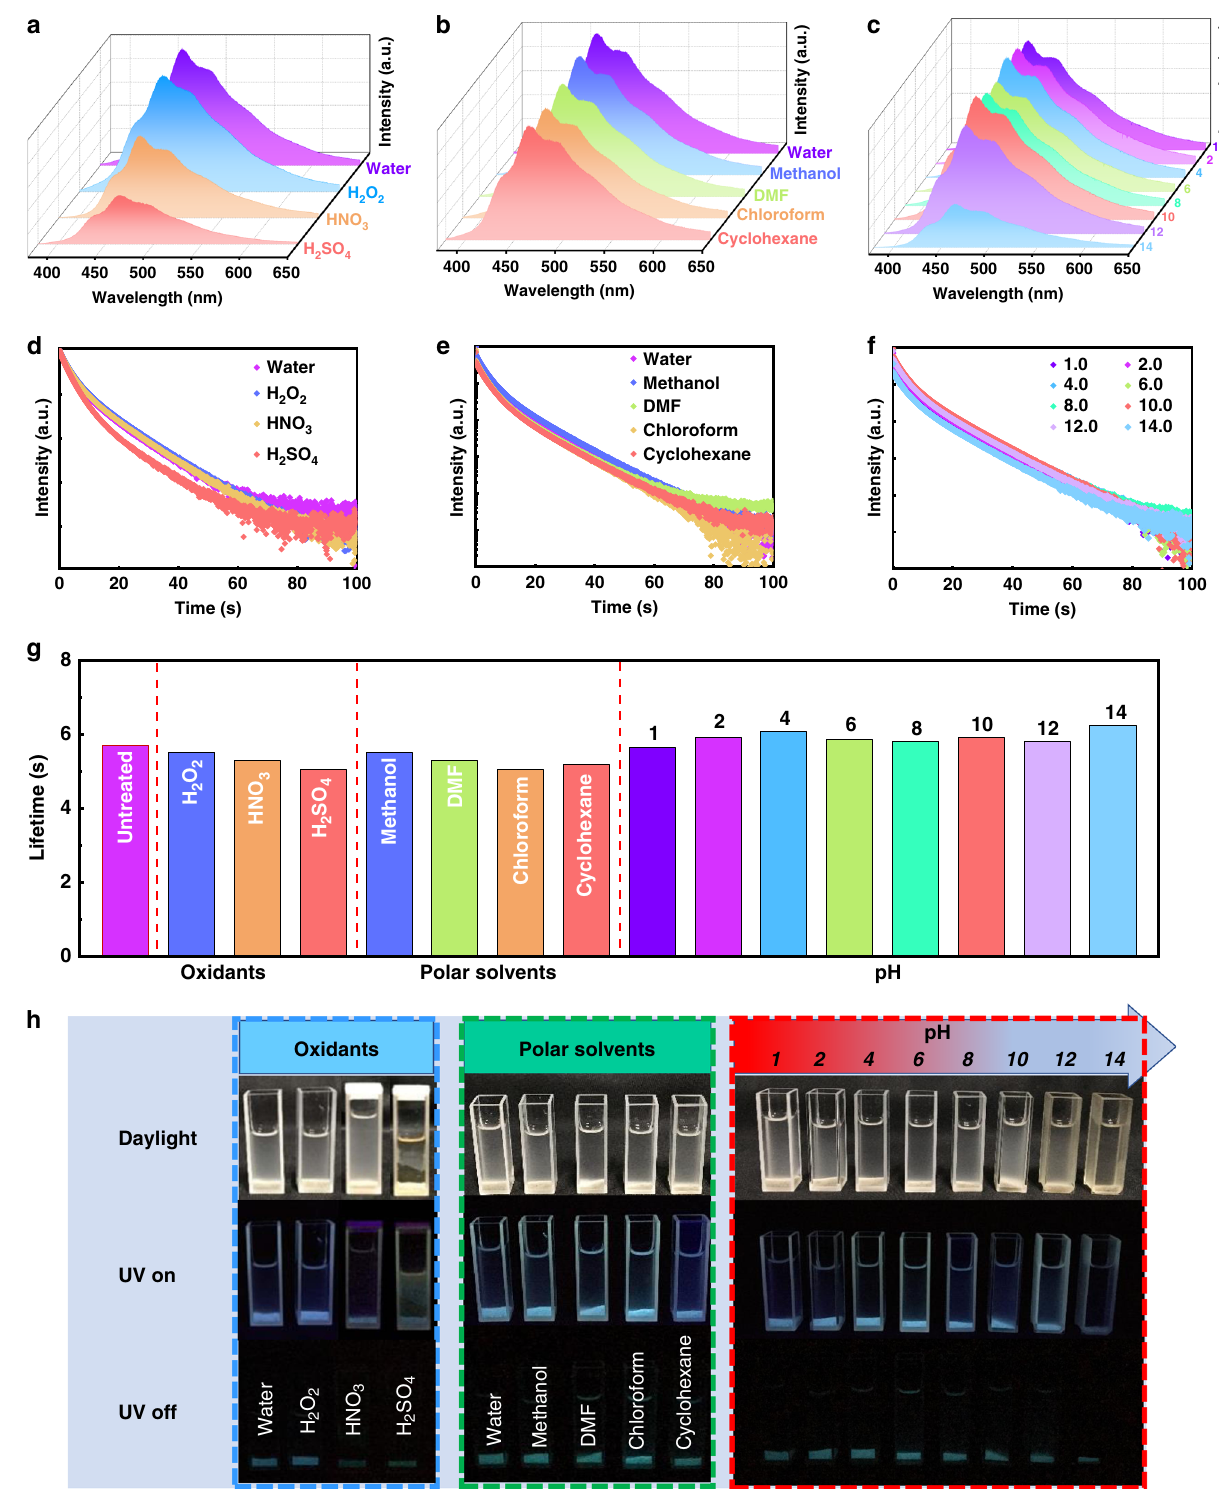
Fig. 5 Stability of the resultant CDs@SiO 2 against strong oxidants, strong acids and bases, water, and polar solvents. a , d Phosphorescence spectra and time-resolved phosphorescence decay of the untreated CDs@SiO 2 -600 and CDs@SiO 2 -600 oxidized by H 2 O 2 (30 wt%), concentrated HNO 3 (30 wt%), or H 2 SO 4 (98 wt%). b , e Phosphorescence spectra and time-resolved phosphorescence decay of the CDs@SiO 2 -600 in solvents with different polarities. c , f Phosphorescence spectra and time-resolved phosphorescence decay of the CDs@SiO 2 -600 under pH values from 1.0 to 14.0. g Phosphorescent lifetime histogram of CDs@SiO 2 -600 in various oxidants, polar solvents, and pH values from 1.0 to 14.0. h Corresponding photographs of CDs@SiO 2 -600 in various oxidants, polar solvents, and water at different pH under sunlight, UV on and